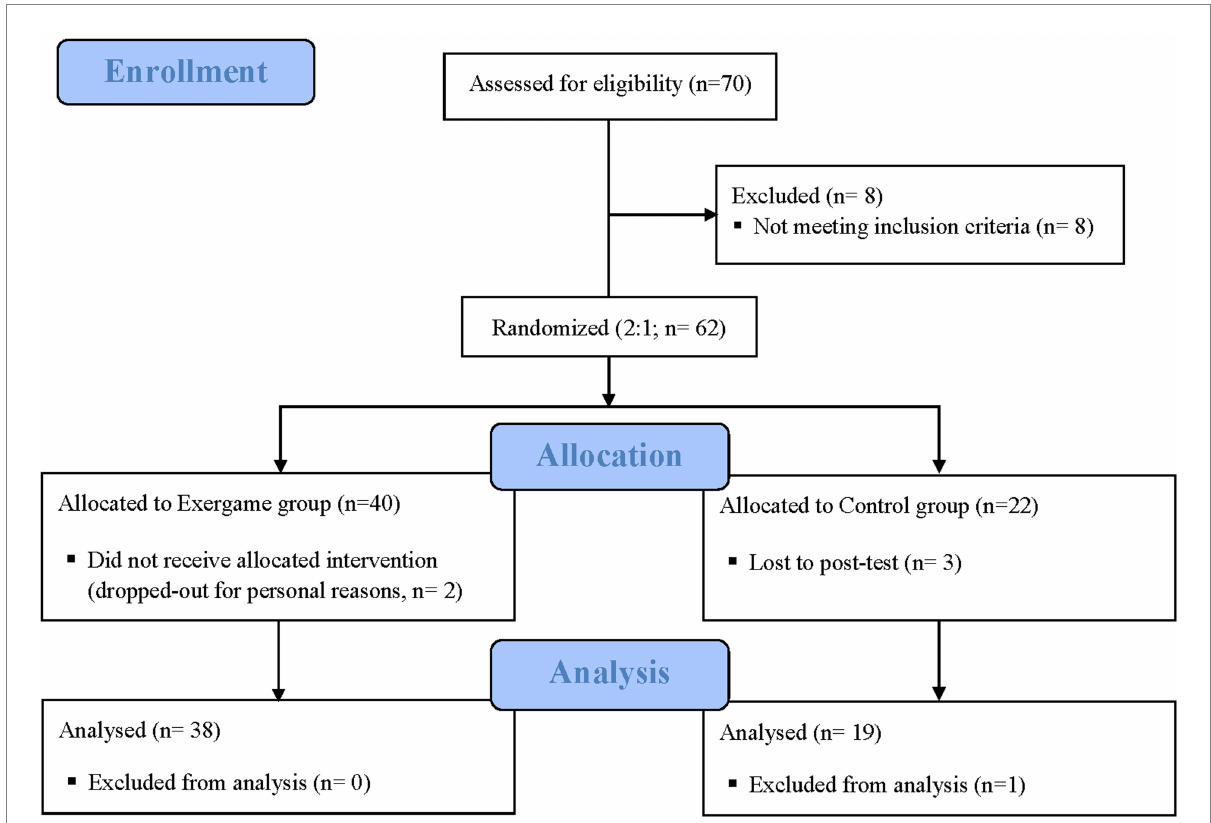
FIGURE 1 Participants’ flow and study design. Participants were randomly assigned to either experimental and control group. Exergame group was trained over eight intensive sessions for 45 min a day. A comprehensive neuropsychological battery was administered to both